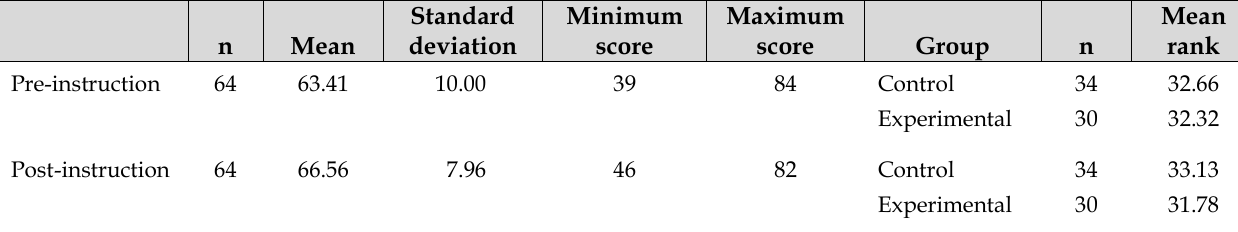
Table 4 Information literacy self-efficacy pre- and